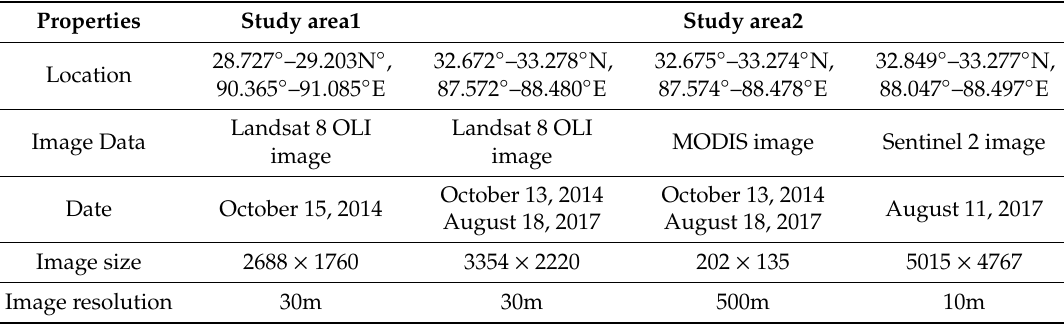
Table 1. Main characteristics of the two study areas and the data information.